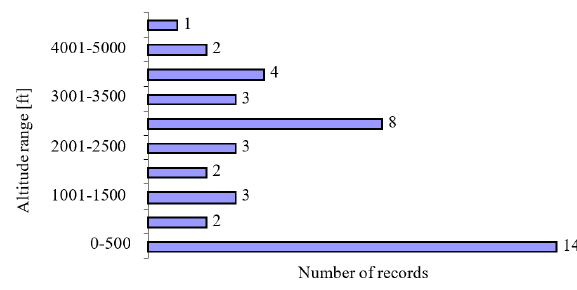
Figure 4. Records classification based on encounter altitude